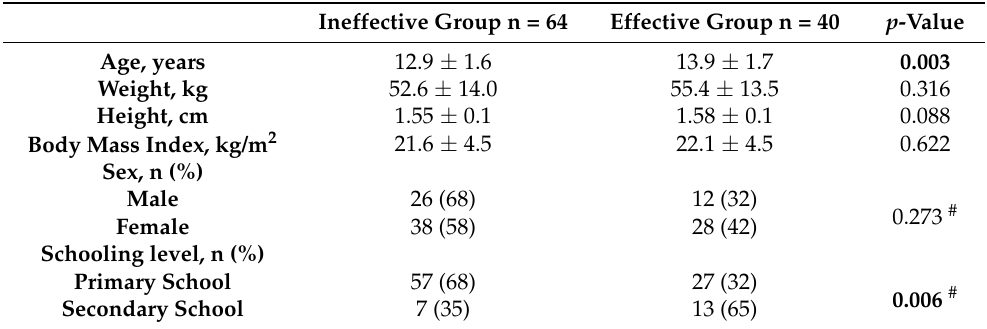
Table 1. Demographic characteristics and educational level are presented as mean value and standard deviation or number of subjects and proportion between effective and ineffective groups.